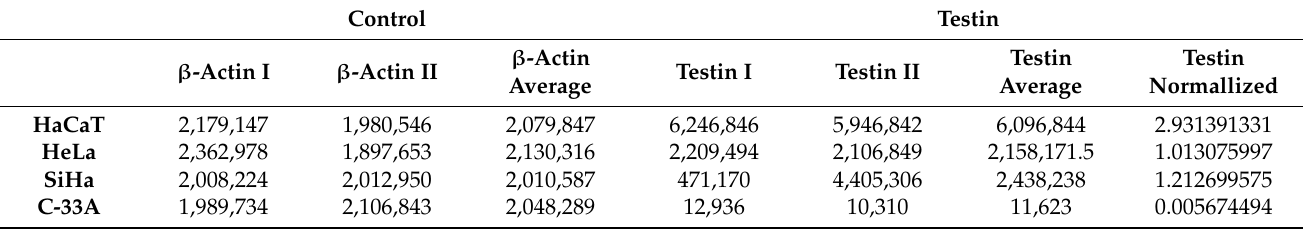
Table 3. Quantification of the WB bands for testin and β